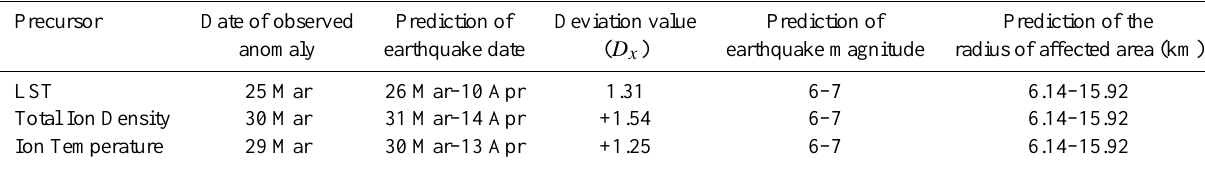
Table 7. Different precursors concerning Borujerd earthquake (Akhoondzadeh, 2011).